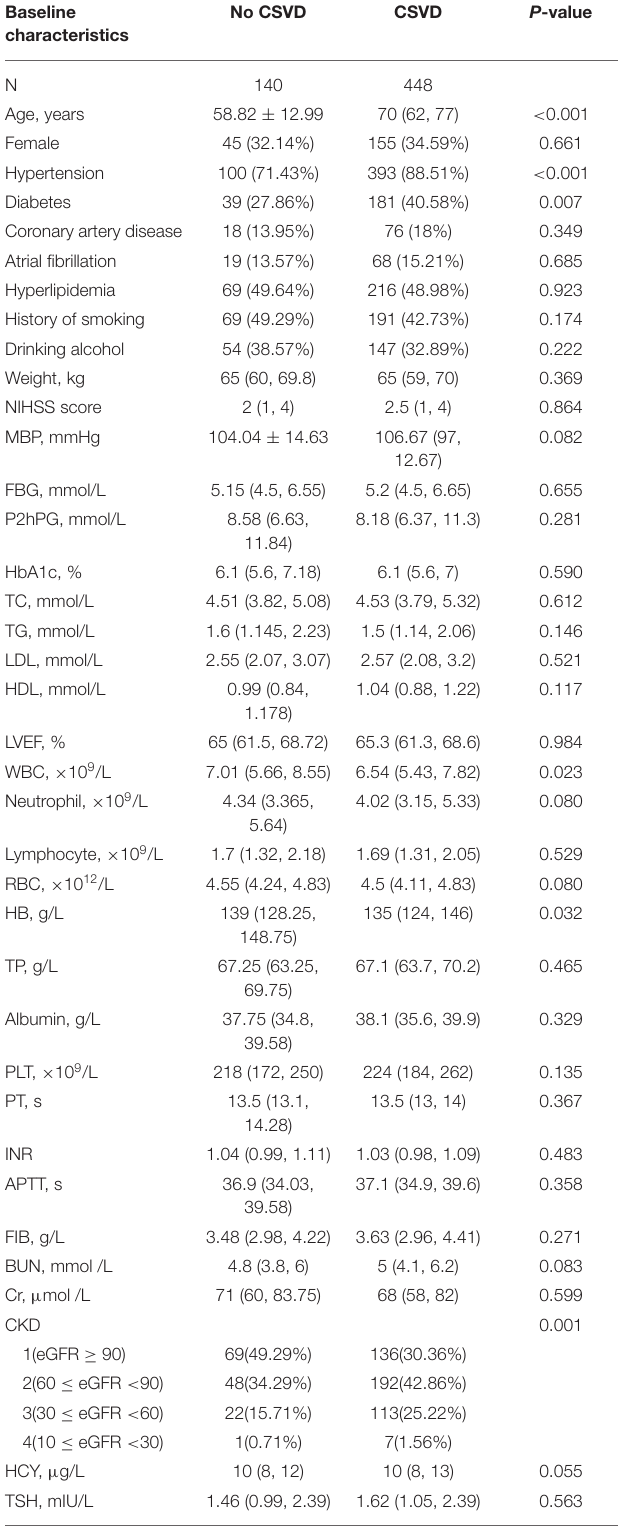
TABLE 1 | The general characteristics of patients without cerebral small vessel disease (CSVD) and with CSVD. Baseline